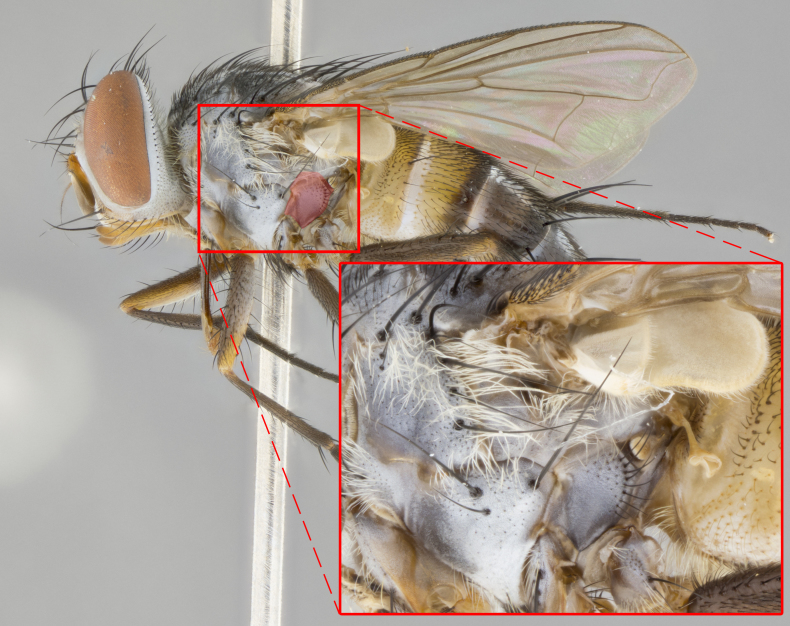
lateral habitus of Telothyria
grisea
sp. n. female (voucher n. DHJPAR0038741) inset detailing the presence of "normal" meral setae.